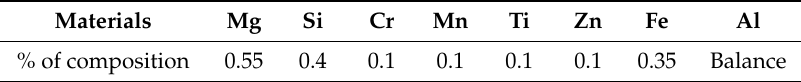
Table 1. Chemical composition of AA6063 aluminum alloy.